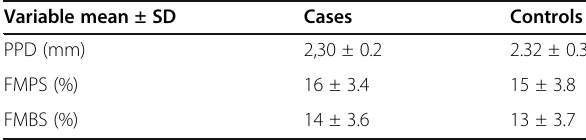
Table 1 Participants ’ clinical periodontal parameters: SD - standard deviation; PPD - pocket probing depth; FMPS - full mouth plaque score, FMBS - full-mouth bleeding score Variable mean ± SD